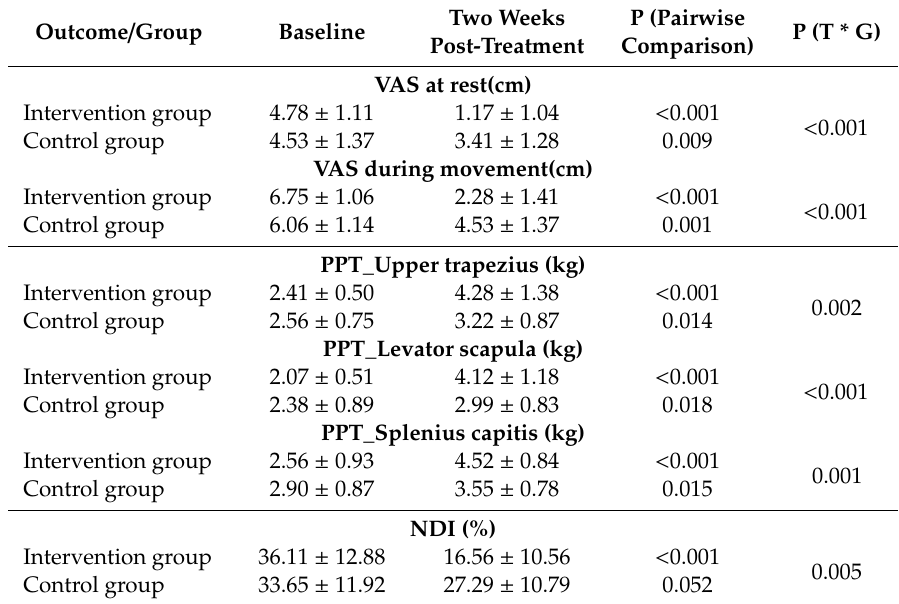
Table 2. The changes in pain intensity, pain pressure threshold, and neck